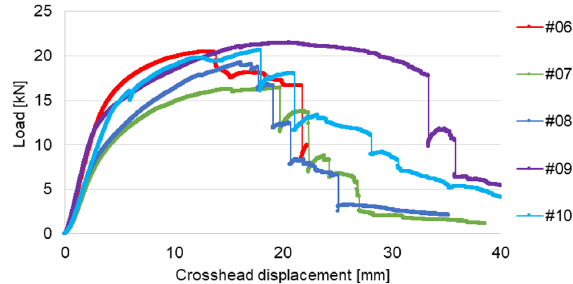
Figure 7. Load vs. crosshead displacement of the group one beams with the first failures F2 - splinter around the ligament + shear.